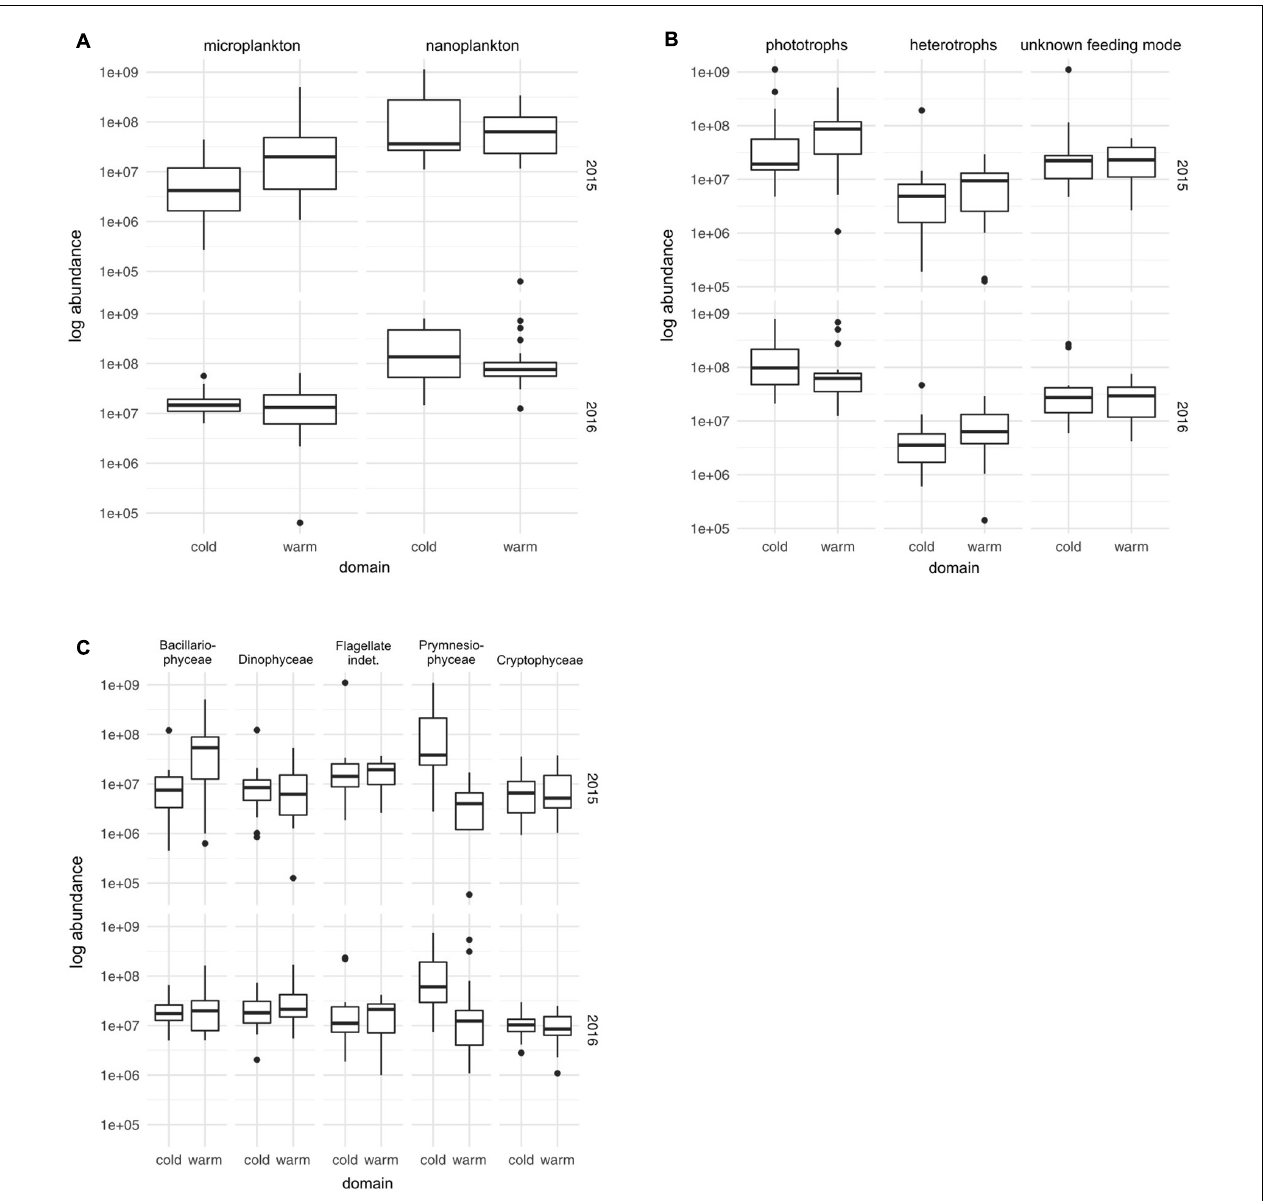
FIGURE 5 | Box plots of the abundance (a log scale) of nanoplanktonic and microplanktonic protists (A) , of phototrophs, heterotrophs, and protists with unknown feeding mode (B) and of the major protist groups ( > 5% of the total protist abundance) (C) recorded in the colder and warmer water domains (at a 6 ◦ C threshold) in the summers of 2015 and